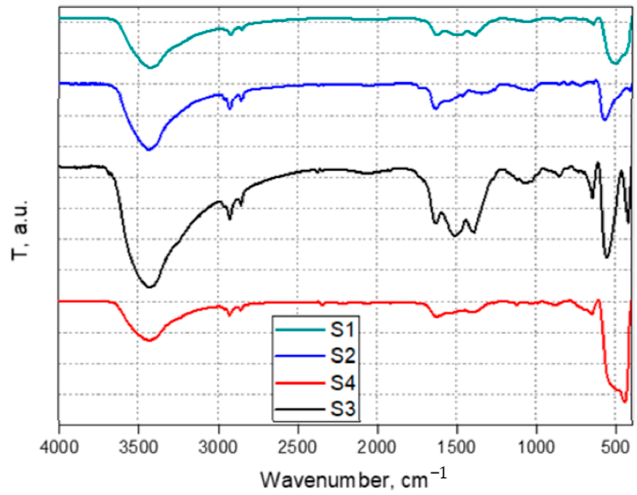
Figure 3. FTIR analysis of the synthesized samples.